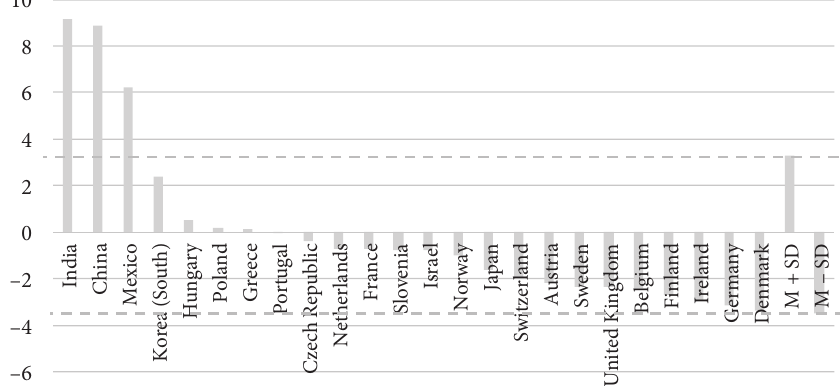
Figure 4. Individual effects for the OTEA exploratory model